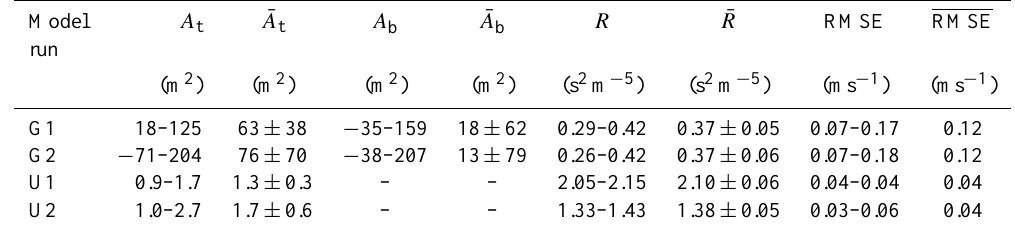
Table 4. Parameters from the error estimate taking uncertainties of Q m and Q p into account: range of A t , mean ¯ A t with mean 95% confidence interval, similarly for A b , ¯ A b , R , ¯ R . Range of RMSE and mean